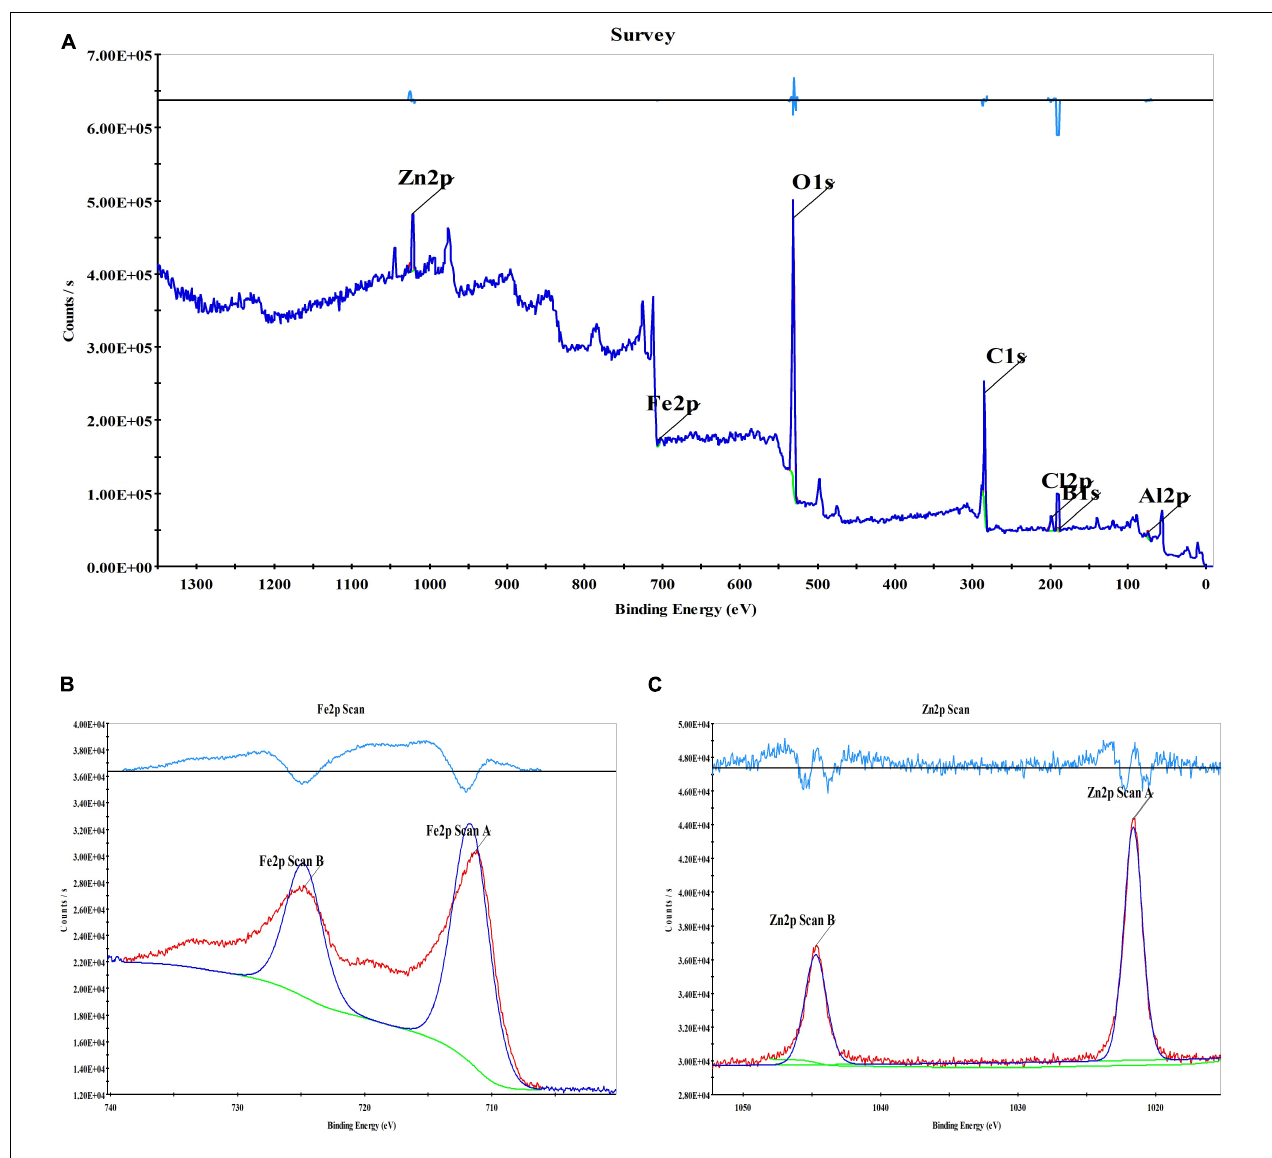
FIGURE 4 | XPS spectrogram of the composite materials (A) , XPS spectrogram of Fe (B) , and XPS spectrogram of Zn (C) .